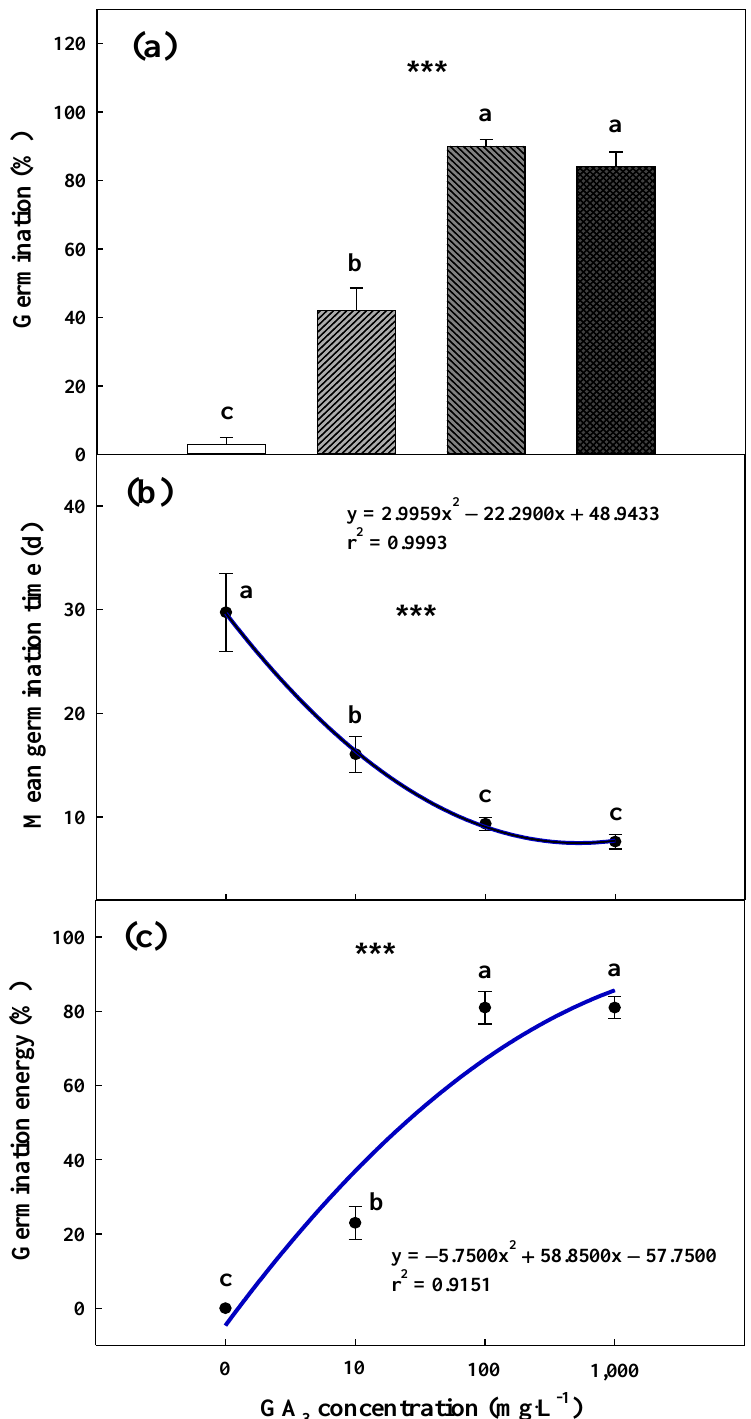
Figure 6. Germination percentage ( a ) and the mean germination time ( b ) of the Gentiana triflora var. japonica (Kusn.) H. Hara seeds pretreated with GA 3 (0, 10, 100, or 1000 mg · L − 1 ) for 30 days. Germination energy ( c ) of the Gentiana triflora var. japonica (Kusn.) H. Hara seeds pretreated with GA 3 (0, 10, 100, or 1000 mg · L − 1 ) for 7 days. Vertical bars represent the standard deviation from the mean ( n = 4). Different letters in the same column indicate significant differences based on Tukey’s multiple range test ( p ≤ 0.05). *** Significant at p ≤ 0.001.